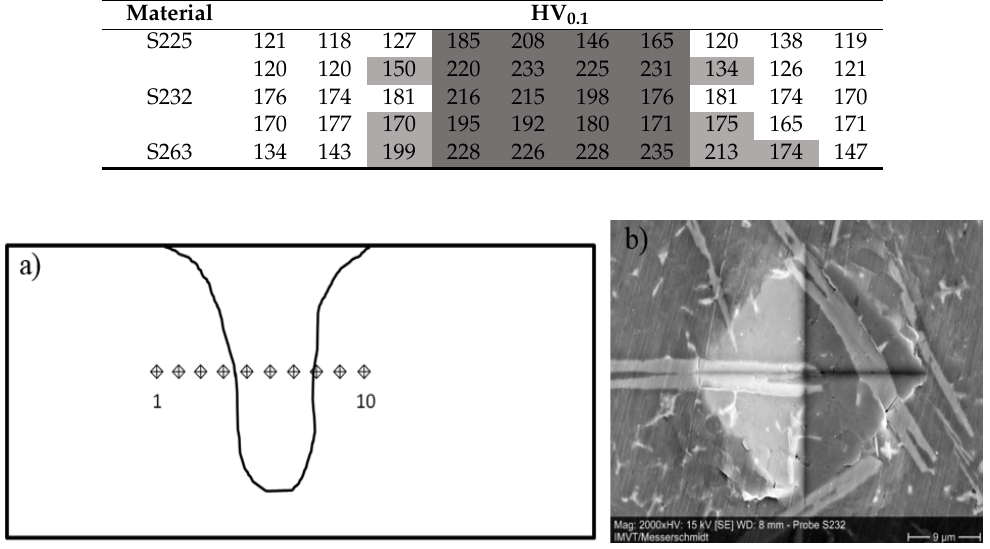
Figure 12. ( a ) Schema of microhardness measurements; ( b ) Detail of micro indentation.